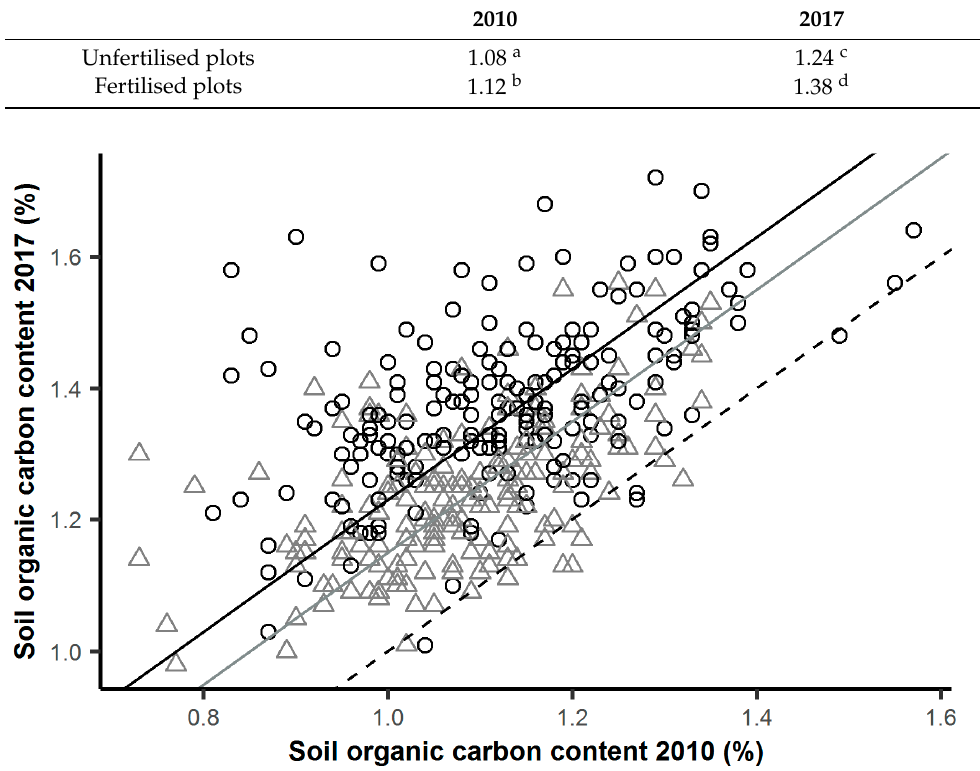
Figure 2. Correlation between SOCc (%) in 2010 and 2017. Unfertilised plots are represented by grey triangles, fertilised plots by black circles. The dashed line is the 1:1 line. The grey line shows the mean increase for the unfertilised plots (y = 0.16 + x) and the black line shows the mean increase for the fertilised plots (y = 0.26 + x).